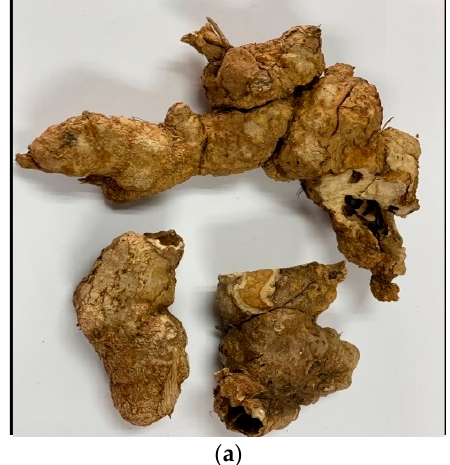
Figure 3. ( a ) Smilax corbularia ; ( b ) Smilax glabra.